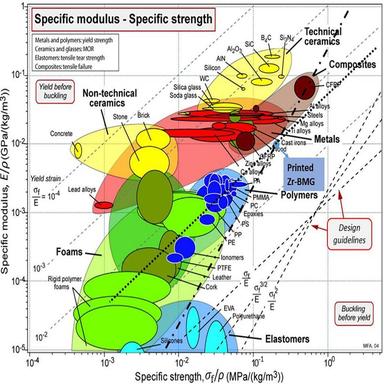
Position of the LPBF printed Zr-based BMG in the diagram of specific modulus versus specific strength (modified from).